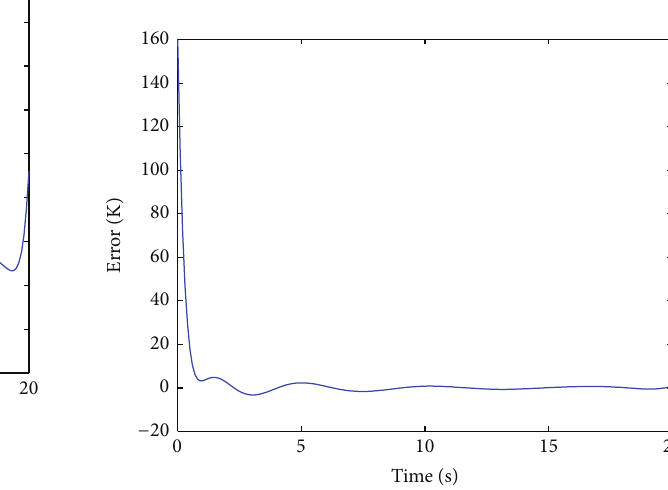
Figure 9: Controlled variable.